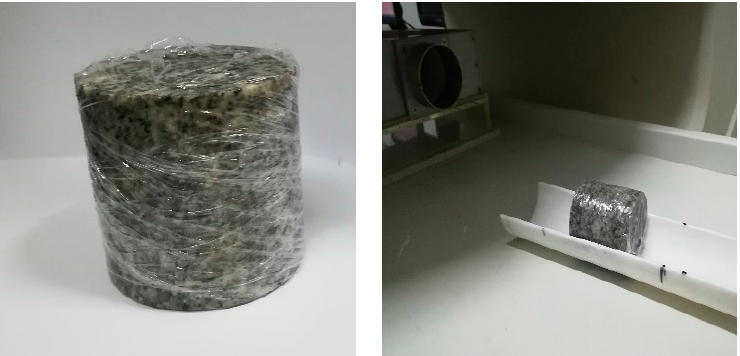
Figure 2. Preparation of rock samples before testing.